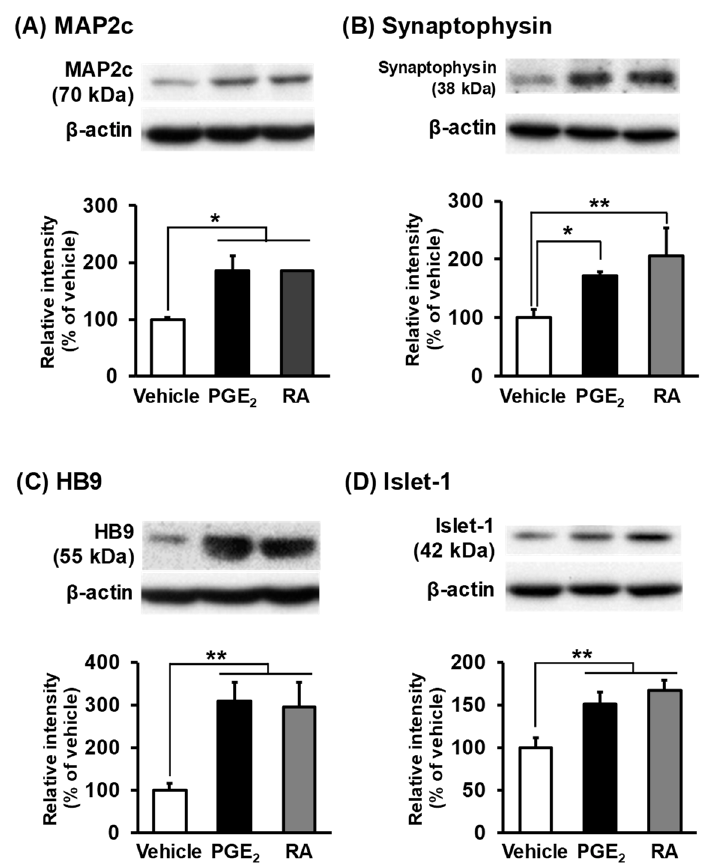
Figure 6. Expression of motor neuron-specific markers in NSC-34 cells. Undifferentiated NSC-34 cells were treated with a vehicle (EtOH), 30 µ M PGE 2 for 2 days, or 10 µ M RA for 7 days. Photograph shows a representative result of a Western blot of low-molecular-weight microtubule-associated protein-2 (MAP2c) ( A ), synaptophysin ( B ), HB9 ( C ) and Islet-1 ( D ) with β -actin as an internal marker. Graphs show the relative densities of bands on the blots estimated quantitatively using Scion imaging software. Each value represents the mean ± SD ( n = 3). * p < 0.05, ** p < 0.01.